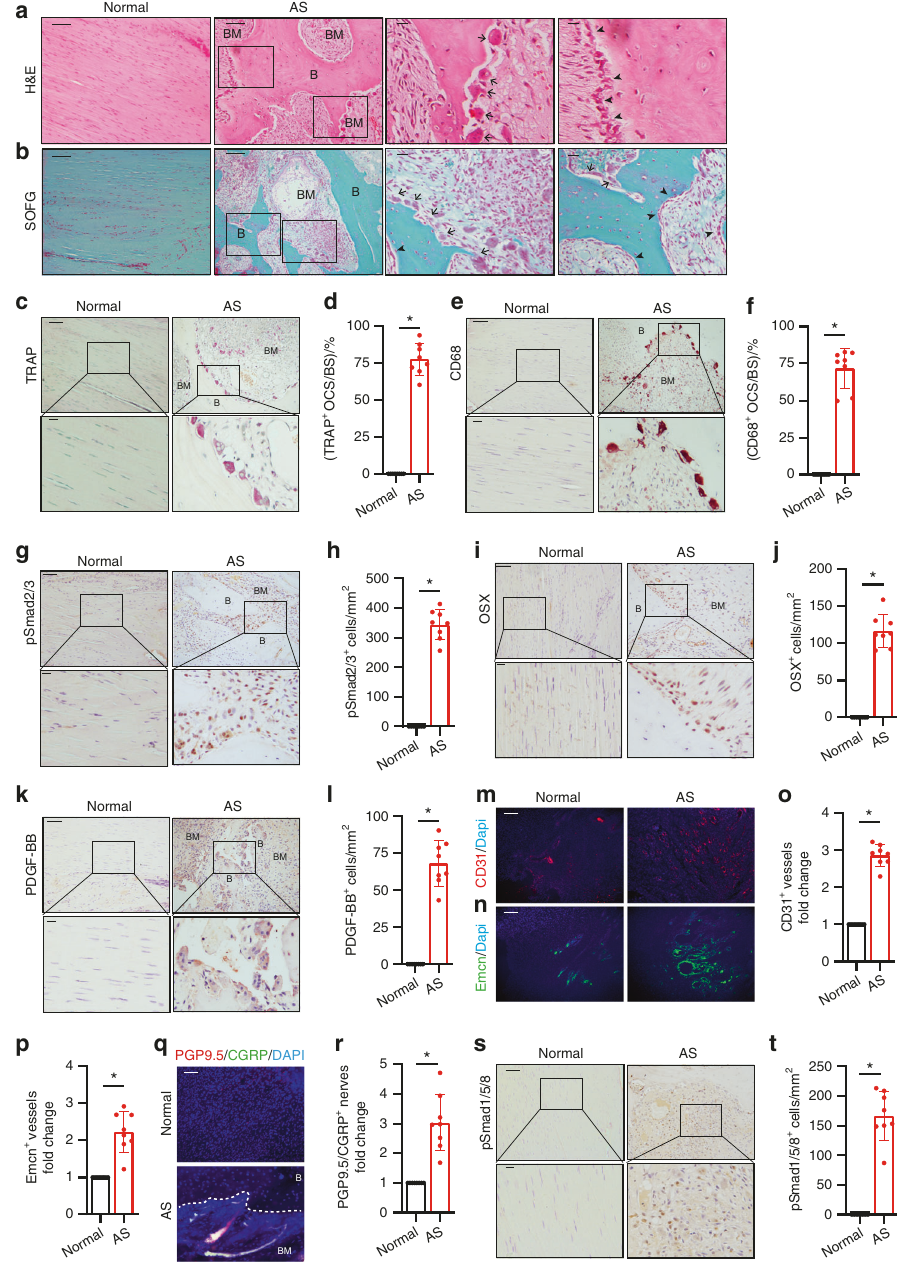
Fig. 5 Osteoclast resorption of bony interspinous ligaments releases active TGF- β to drive the progression of ossi fi cation in AS patients. a Hematoxylin and eosin (H&E) staining and b Safranin O – Fast Green staining of normal and HO-formed interspinous ligaments. In the AS group, the right panels show magni fi ed views of the boxed area in the left panels. Scale bar: 100 μ m (two panels on the right); 25 μ m (two panels on the left). c Tartrate-resistant acid phosphatase (TRAP)-positive cells (red) and d quantitative analysis of the TRAP-positive osteoclast surface (OCS) per bone surface. The bottom panels show magni fi ed views of the boxed area in the top panels. Scale bar: 100 μ m (top panel); 25 μ m (bottom panel). e Immunostaining and f quantitative analysis of CD68-positive cells (brown) in the normal and HO-formed interspinous ligaments (sagittal view). The bottom panels show magni fi ed views of the boxed area in the top panels. Scale bar: 100 μ m (top panel); 25 μ m (bottom panel). g Immunostaining and h quantitative analysis of pSmad2/3-positive cells in the normal and HO-formed interspinous ligaments (sagittal view). The bottom panels show magni fi ed views of the boxed area in the top panels. Scale bar: 100 μ m (top panel); 25 μ m (bottom panel). i Immunostaining and j quantitative analysis of Osterix-positive cells (brown) in the normal and HO-formed interspinous ligaments (sagittal view). The bottom panels show magni fi ed views of the boxed area in the top panels. Scale bar: 100 μ m (top panel); 25 μ m (bottom panel). k Immunostaining and l quantitative analysis of PDGF-BB-positive cells in the normal and HO-formed interspinous ligaments (sagittal view). The bottom panels show magni fi ed views of the boxed area in the top panels. Scale bar: 100 μ m (top panels); 25 μ m (bottom panels). m CD31-positive (red) cells, n EMCN- positive (green) cells and quanti fi cation of the fold change of o CD31-positive vessels, p EMCN-positive vessels in the normal and HO-formed interspinous ligaments (sagittal view). q PGP9.5-positive (red) cells and CGRP-positive (green) cells and quanti fi cation of the fold change of r PGP9.5 and CGRP double positive nerves in the normal and HO-formed interspinous ligaments (sagittal view). s Immunostaining and t quantitative analysis of pSmad1/5/8-positive cells (brown) in the normal and in fl ammatory interspinous ligaments (sagittal view). The bottom panels show magni fi ed views of the boxed area in the top panels. Scale bar: 100 μ m (top panels); 25 μ m (bottom